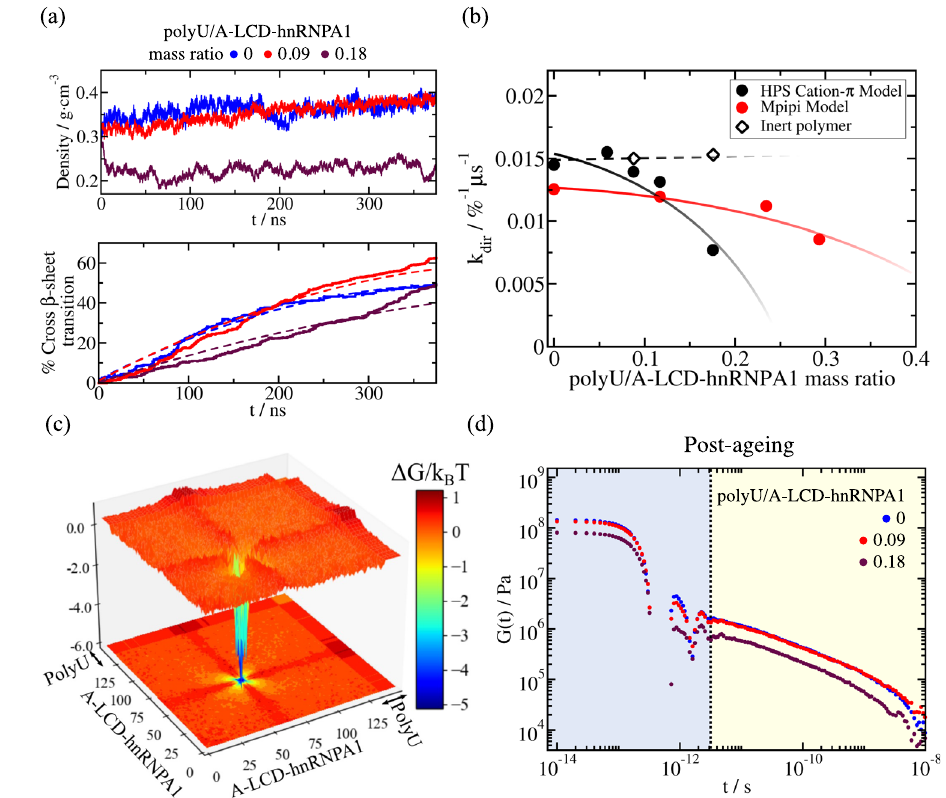
Fig. 5 | A-LCD-hnRNPA1 droplet ageing driven by disorder-to-order transitions is decelerated by inclusion of high polyU RNA concentration. a Time-evolution of droplet density (Top) and percentage of inter-protein β -sheet transitions within the condensates (Bottom) measured at different polyU/A-LCD-hnRNPA1 mass ratios and at T =0.97 T c (where T c refers to the critical temperature of the pure protein condensate). Dashed lines in the bottom panel depict the second-order reaction fi tsemployedtoevaluatethekineticconstant( k dir )ofinter-protein β -sheet formation (see details on the Supplementary Methods). b Estimated kinetic con- stantsfromasecond-orderreactionanalysistothenumberofinter-protein β -sheet transitions over time for different polyU/A-LCD-hnRNPA1 mass ratios at T =0.97 T c using two different residue-resolution models: HPS-Cation- π (black circles, 107 – 109 ) and Mpipi (red circles, 110 ). Black empty diamonds account for test control